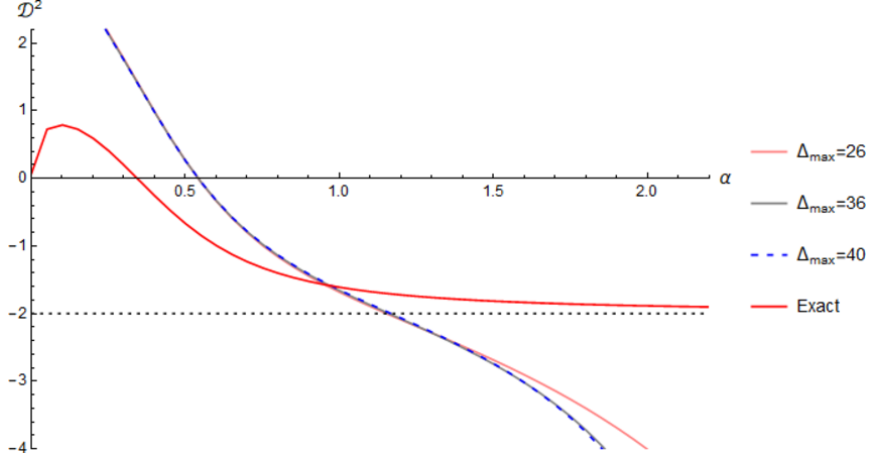
Figure 9. D 2 ( e 1 (cid:0) e 0 ) versus (cid:11) > 0 for the (cid:12)xed spectator.